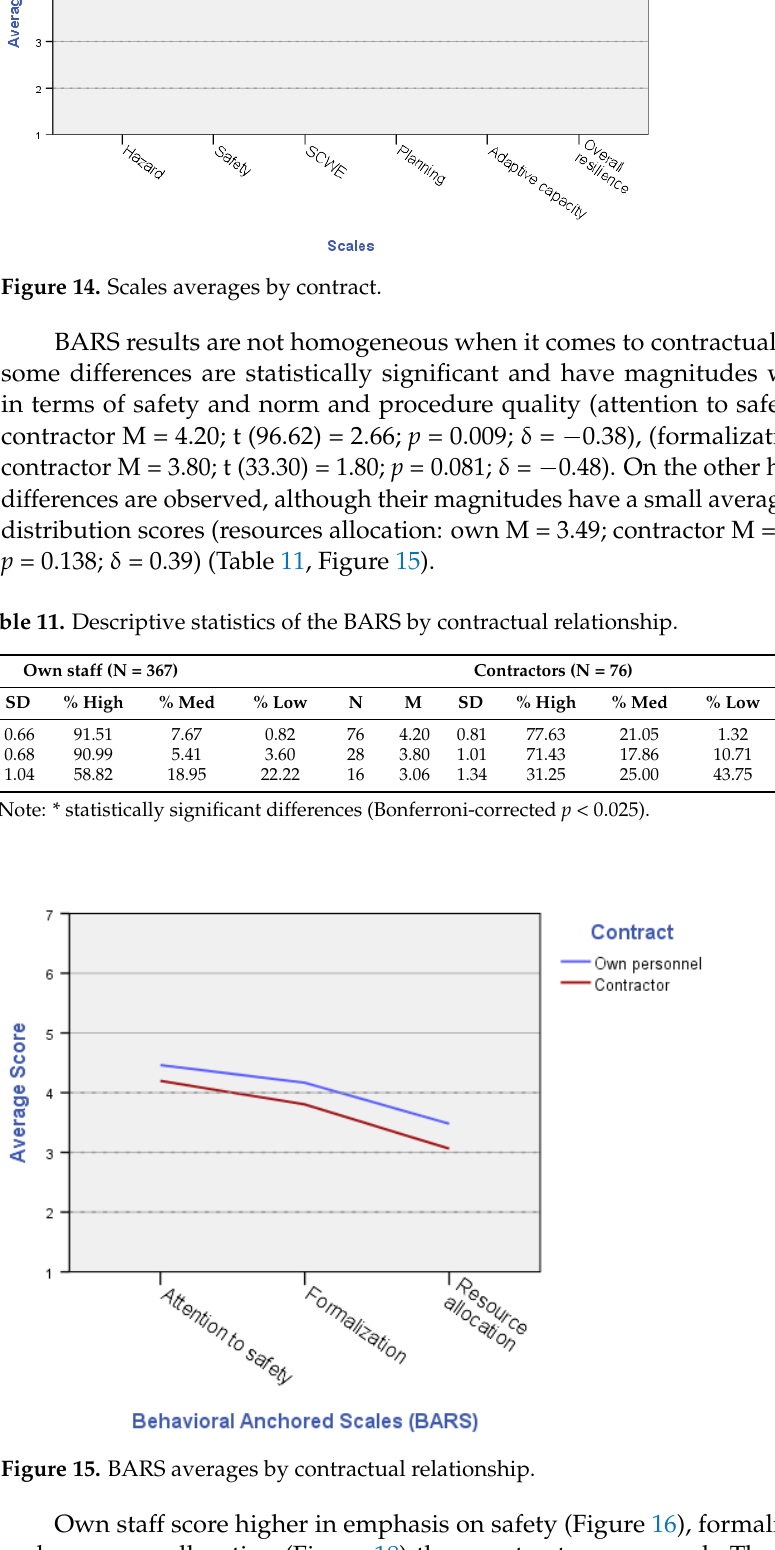
17 of 25 Figure 13. Categorized BARS percentages for resources allocation, by location. 3.2.3. Differences by Contractual Relationship (Own Staff/Contractor) Personnel in nuclear power plants score homogeneously in the safety and hazard perception scales, but show differences in the remaining survey scales. Own staff score higher than contractors in SCWE scales (own M = 5.07; contractor M = 4.47; δ = 0.43), plan- ning (own M = 5.69; contractor M = 5.24; δ = 0.44), adaptive capacity (own M = 4.77; con- tractor M = 4.38; δ = 0.31), and overall resilience (own M = 5.23; contractor M = 4.81; δ = 0.40). That is, contractor personnel have a lower perception of blame-free environment and lower organizational resilience (Table 10, Figure 14). Table 10. Descriptive statistics of the scales by contractual relationship. Own staff (N = 1715)